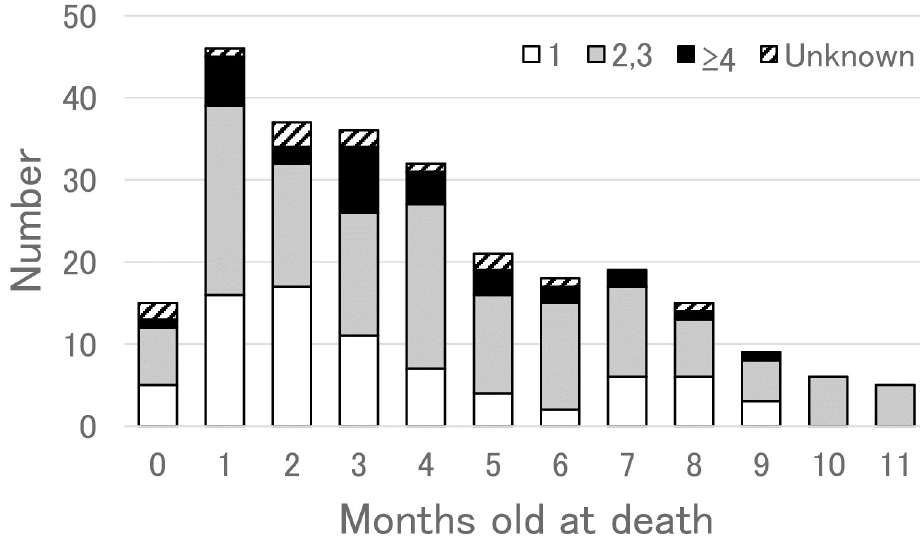
Fig 1. Age distribution of SUDI infants during sleep ( n = 259) examined in this study. Key indicates the birth order of infants, in which the column is divided into four groups of the first-born infants (blank), the second- and third-born ones (gray), more than the fourth-born ones (black), and unknown ones (diagonal).